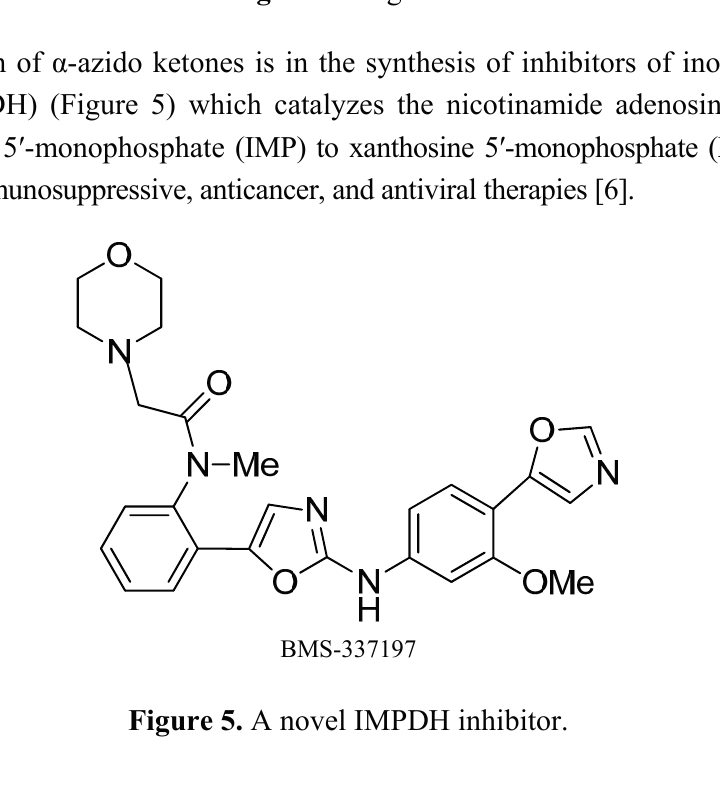
Figure 4. Aegeline.